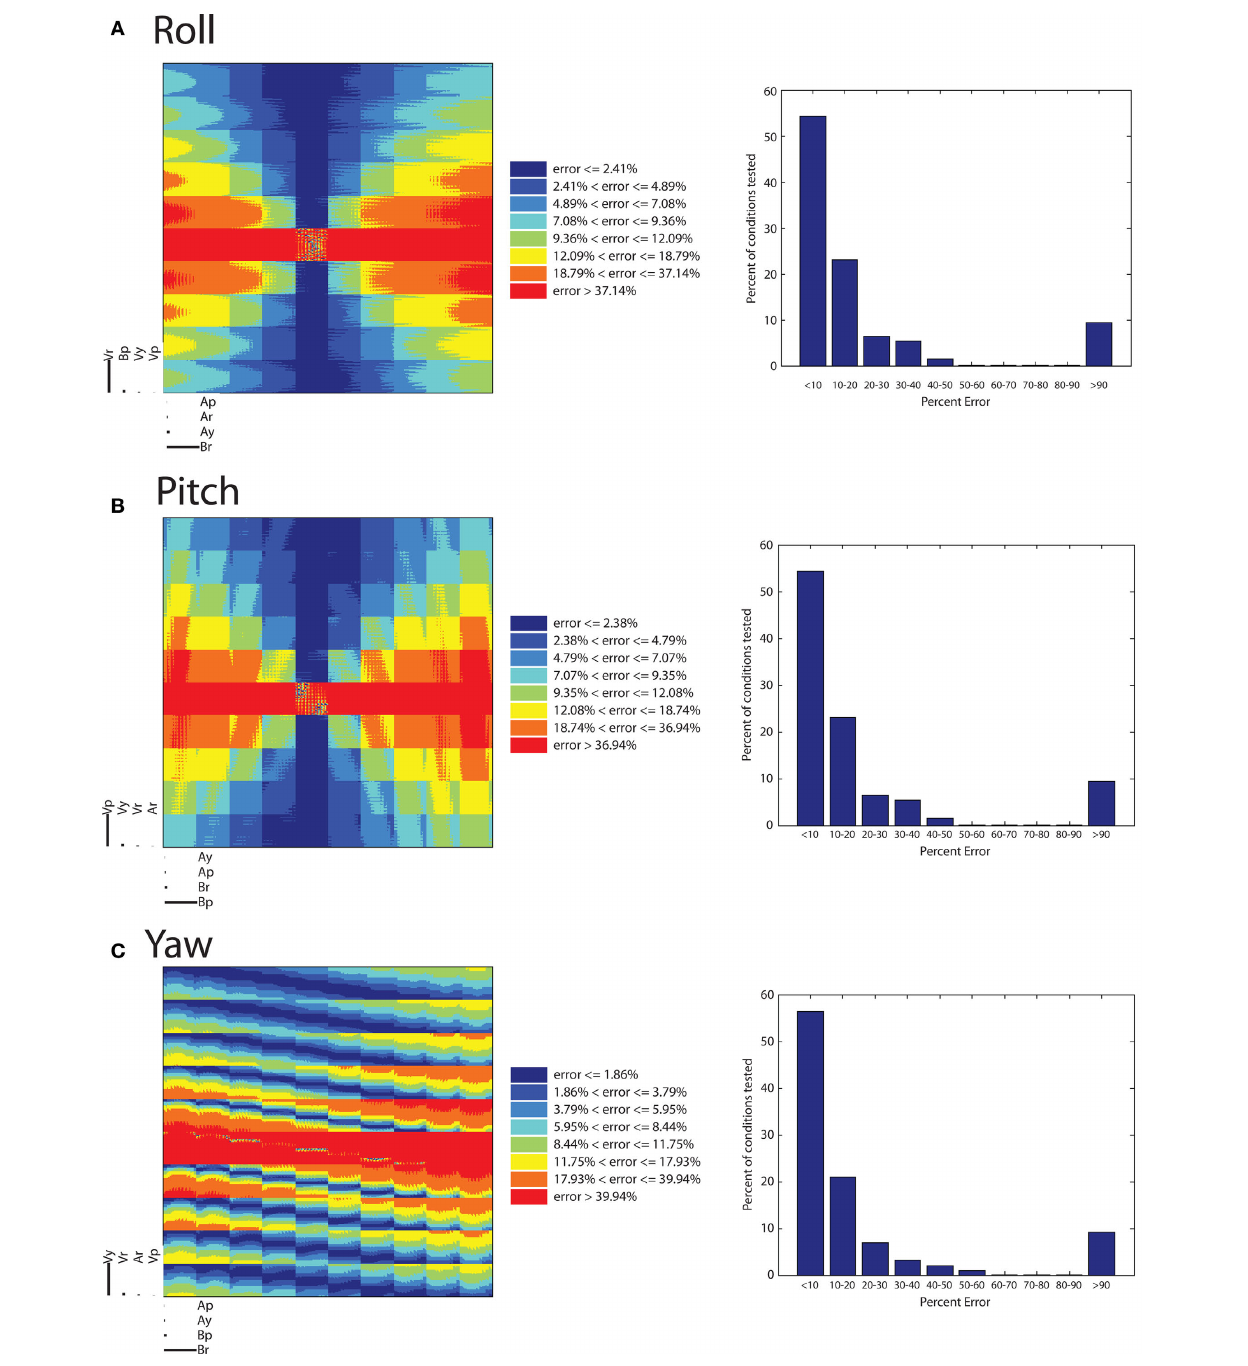
Figure 5 | error analysis. (A–C) Dimensional stacks and histograms of the relative error in roll, pitch, and yaw recovery. 10 values of each parameter were used: initial velocities ( V r, V p, V y) from − 16.1 to 19.9 radians/s, angular accelerations ( A r, A p, A y) from − 50 to 62.5 radians/s 2 , initial body pitch angle ( β p) and initial body roll angle ( β r), from − 50 to 60 °